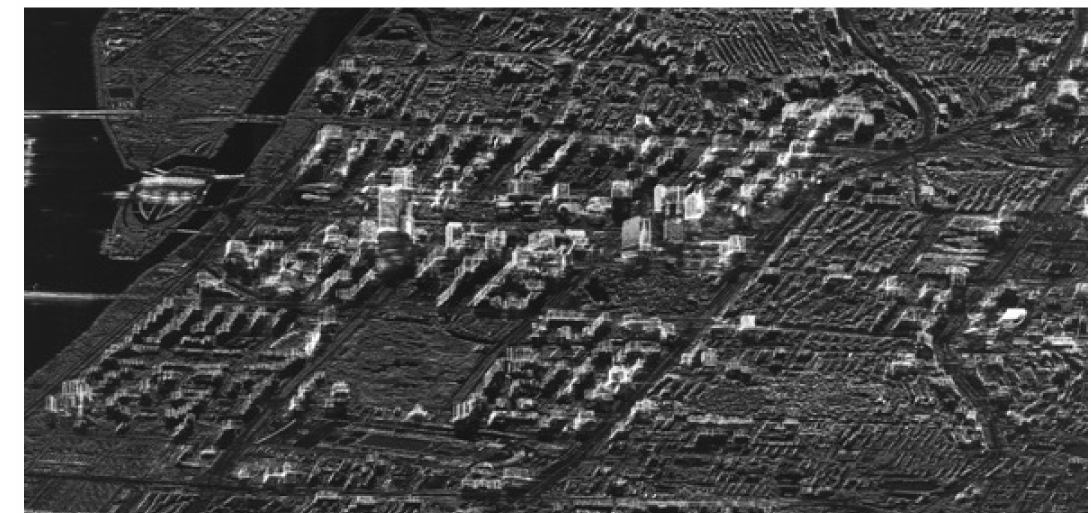
Figure 2. Mean amplitude image of the TSX mono-static pursuit stack over Guangzhou used in our experiment © DLR,